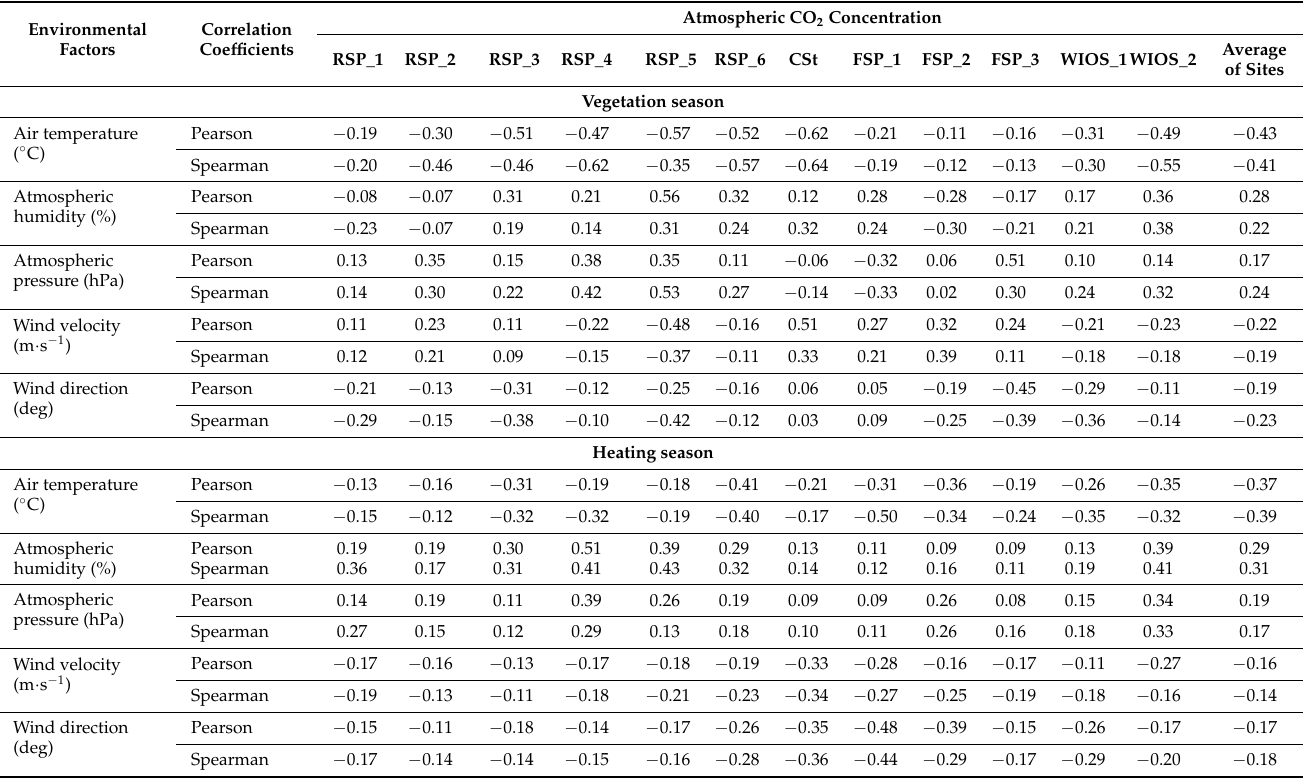
Table 1. Relationship between meteorological variables and observed CO 2 concentrations at the study sites. Environmental